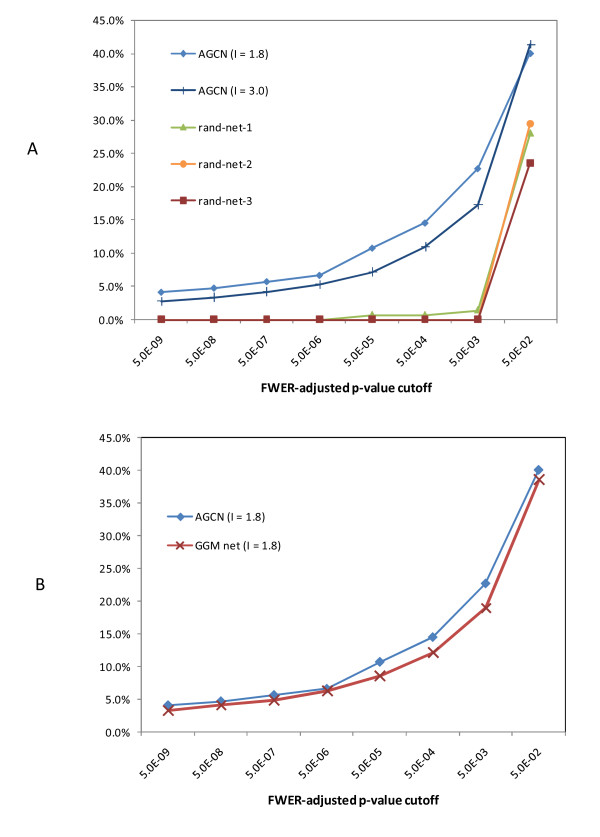
Percentage of modules with three or more members that had significantly over-represented biological process GO terms using different p-value cutoffs. For example, the data points at p-value cutoff of 5.0E-02 indicate the percentage of modules that had enriched GO terms with Bonferroni Family-Wise Error Rate (FWER) adjusted p-values less than 5.0E-02. (A) Comparing AGCN with three random networks. (B) Comparing AGCN with GGM network.